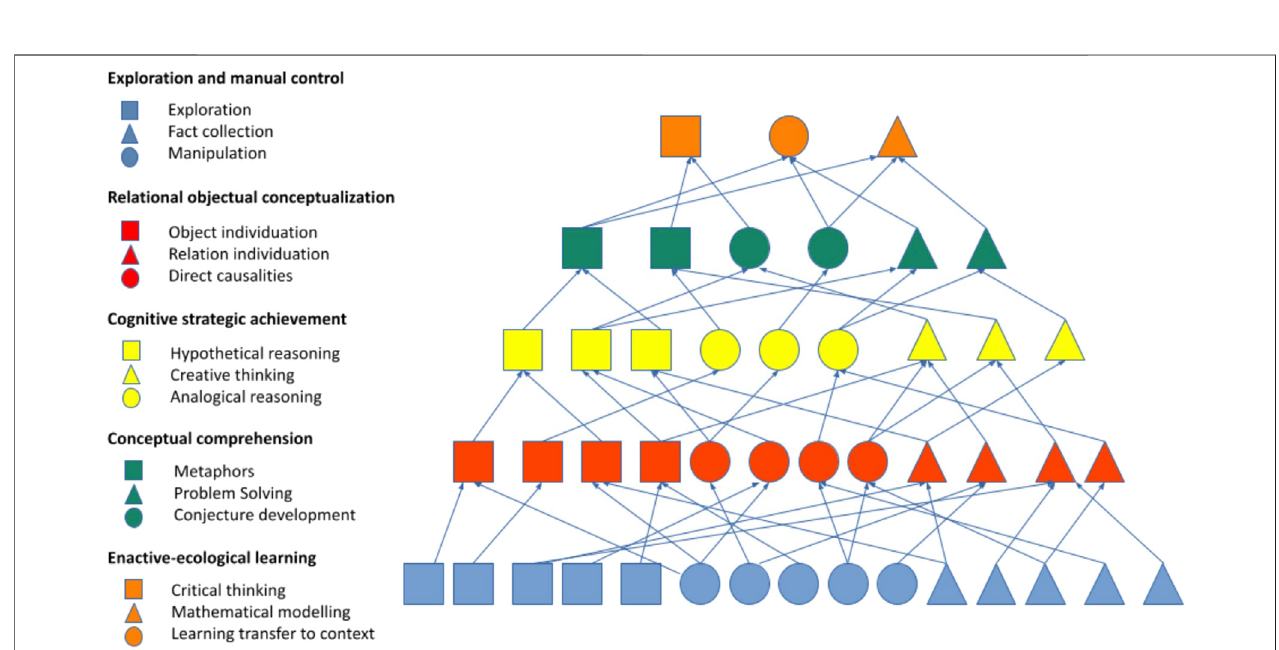
FIGURE 3 | Visualization of STEM/STEAM enactive-ecological pedagogy in the case of a formal and structured curriculum arranged from simple to more complex skills/activities.The fi gurerepresentstheskillfulprogressionintheSTEM/STEAMeducationframeworkwithintheclassroom.Herewecanseethattheorganizationofthe learningexperience beginsfrommanualexplorationtoconceptual understandingand expansivelearning.Thisisnotarestrictivesinglestreetlinearsequence, butrather a path made by walking within a speci fi c STEM/STEAM area or category.